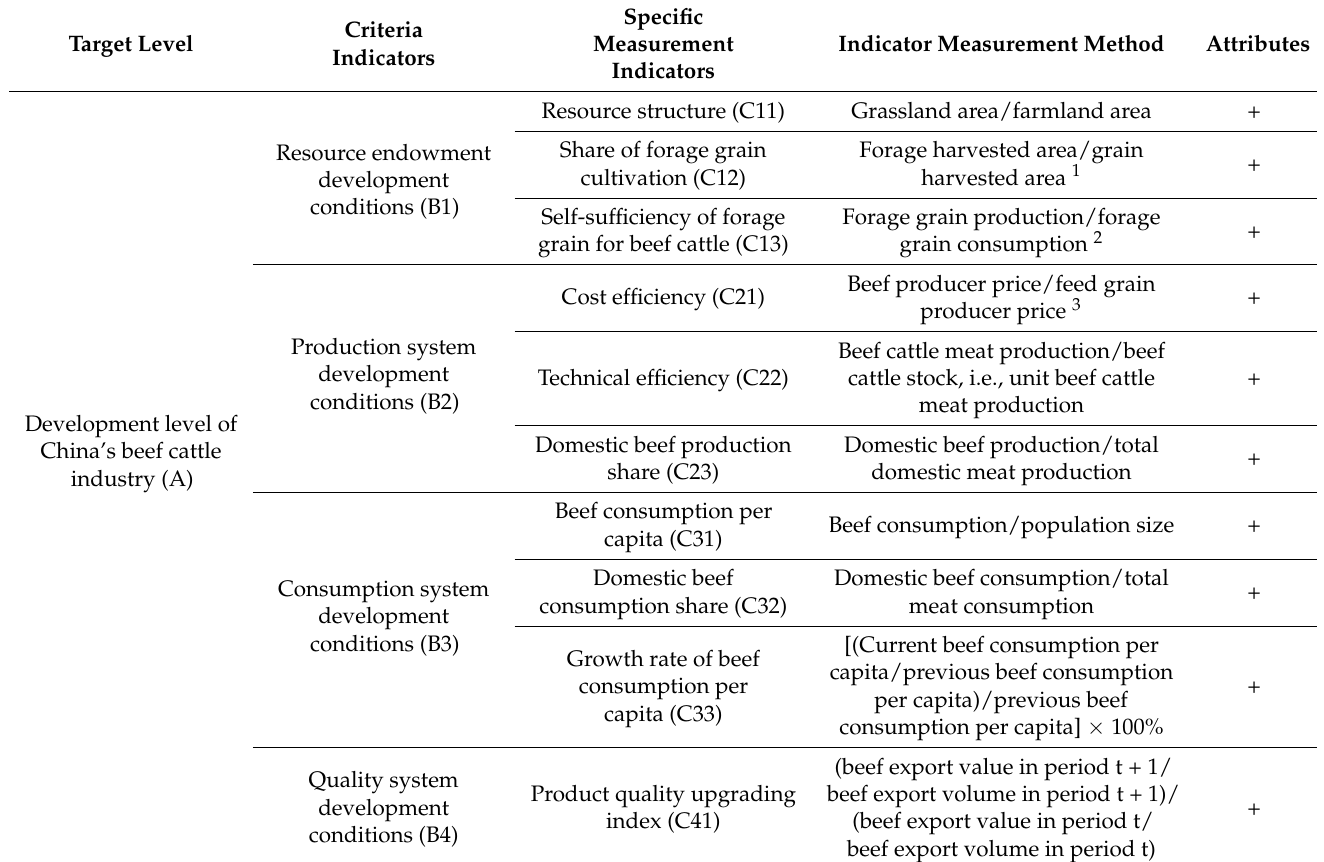
Table 1. Measurement indices and main descriptions of the development level of China’s beef cattle